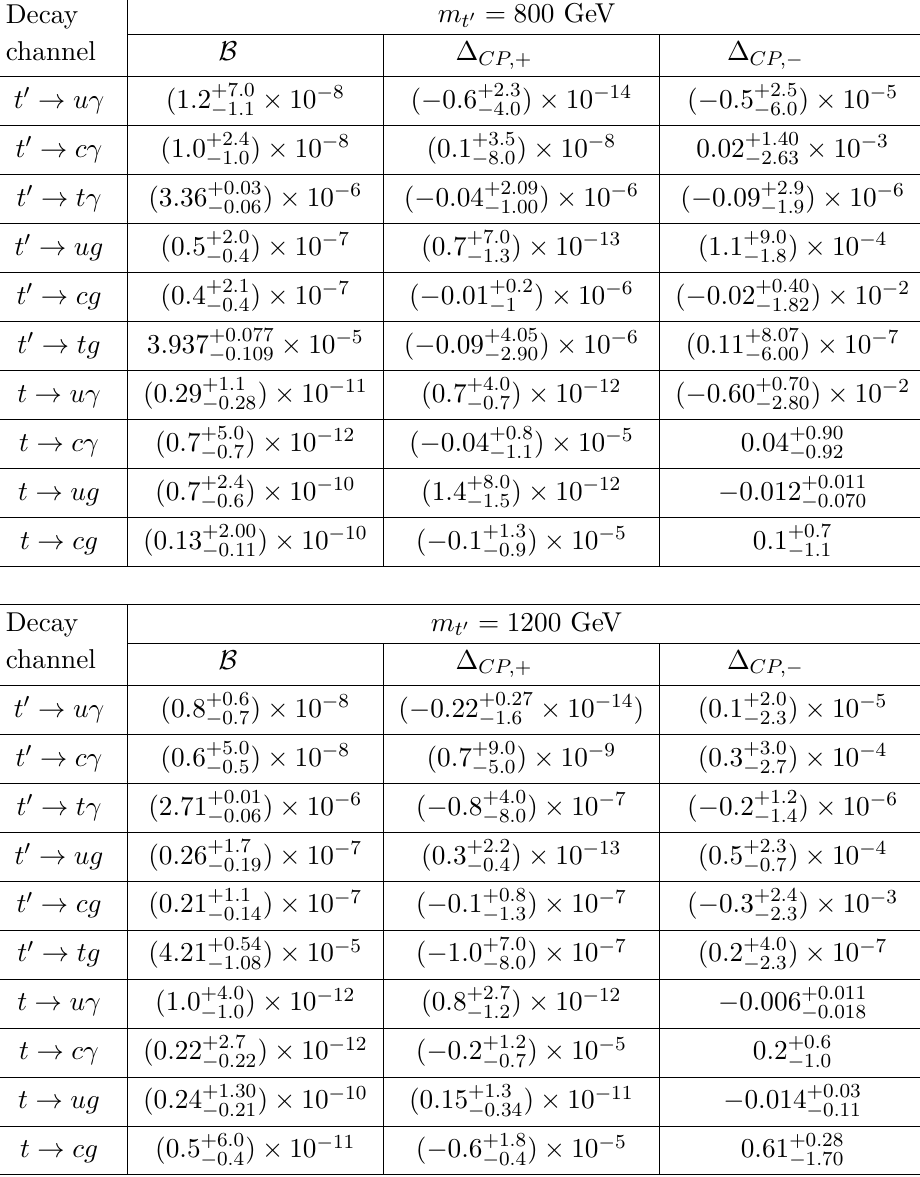
Table 2 . Results for the branching ratios and CP asymmetries for the radiative decay channels of the vector-like quark t 0 and top quark. These are based on the best fit mixing parameters and benchmark masses m t 0 = 800 GeV (top) and m t 0 = 1200 GeV (bottom) outlined in table